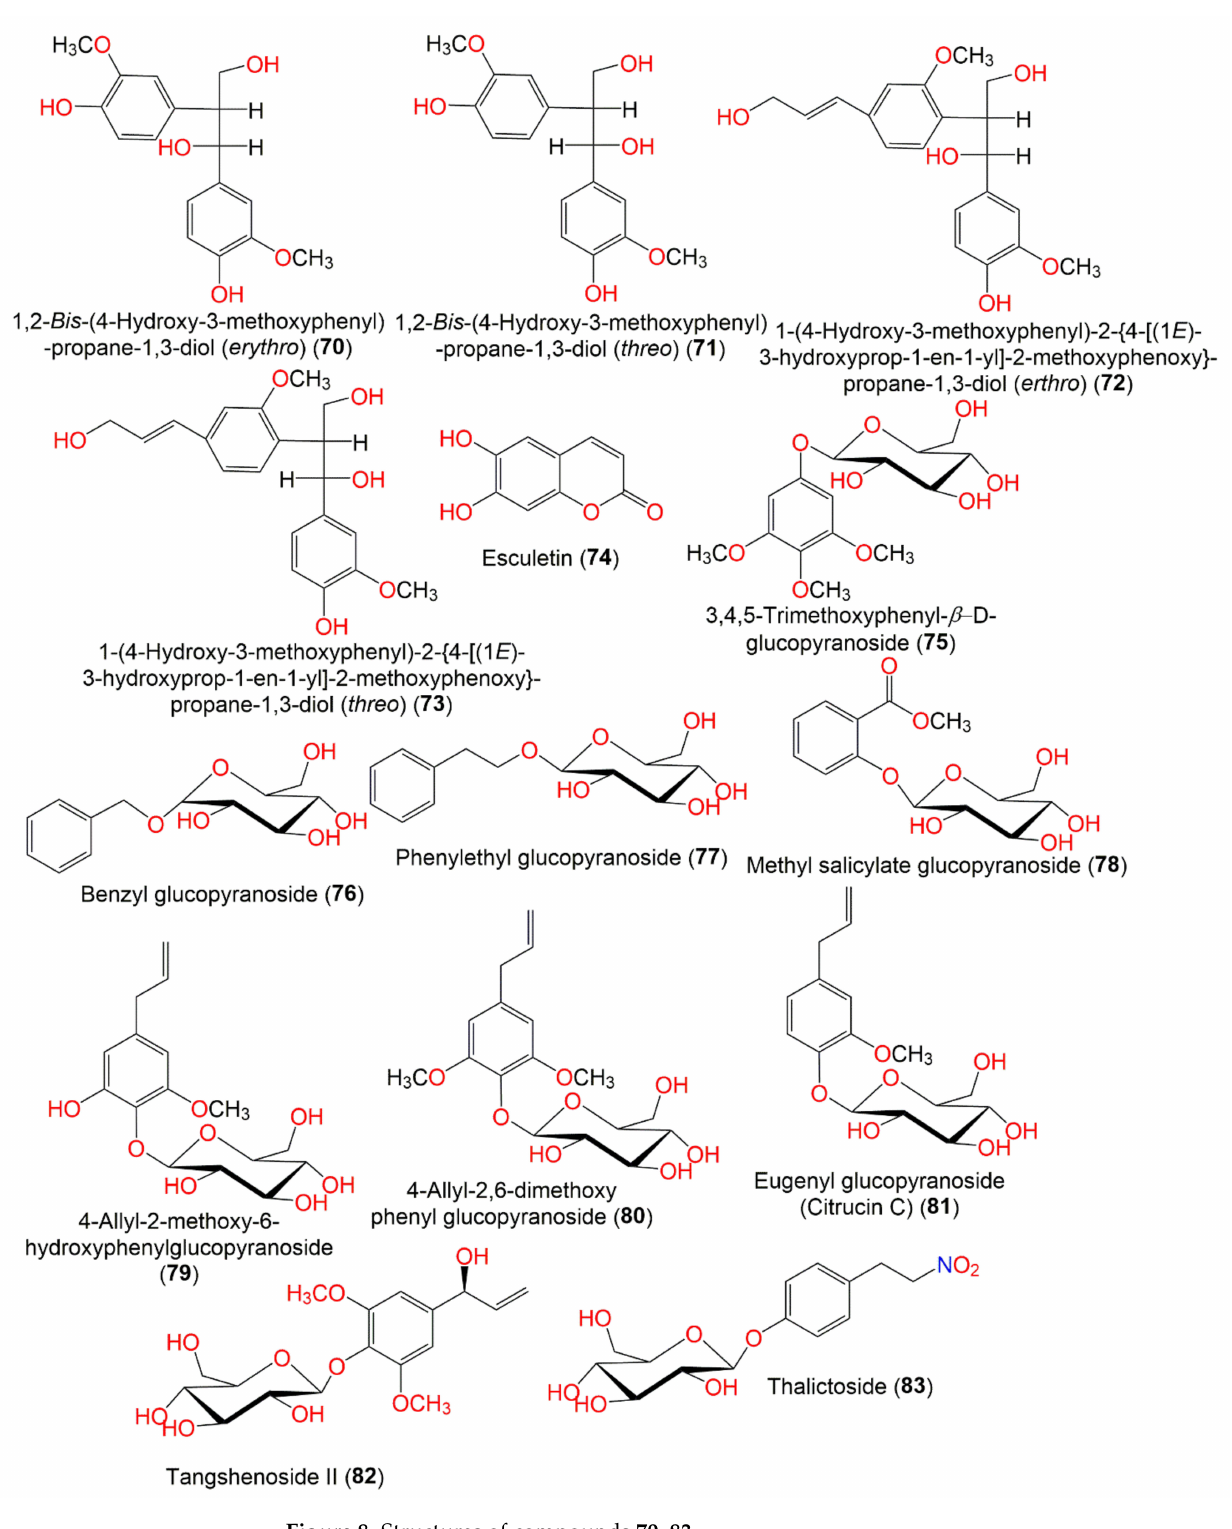
Figure 8. Structures of compounds 70 – 83